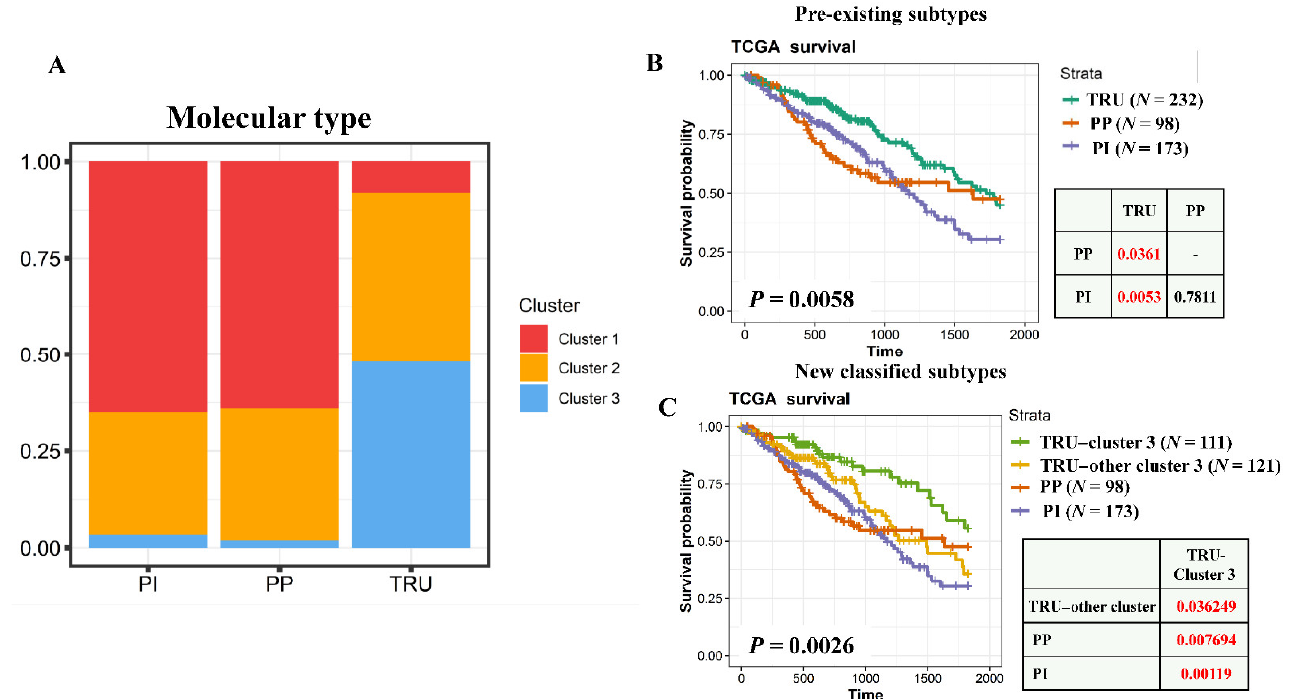
Figure 3. Essential gene-stratified clusters identified a subset from terminal respiratory unit (TRU) tumors with distinct proliferative signatures and prognoses. ( A ) Bar plot showing the frequencies of essential gene-classified clusters in previously defined molecular types. Survival differences within previously defined molecular types ( B ) and essential gene-classified clusters ( C ) are demonstrated as Kaplan-Meier plots using log-rank tests.